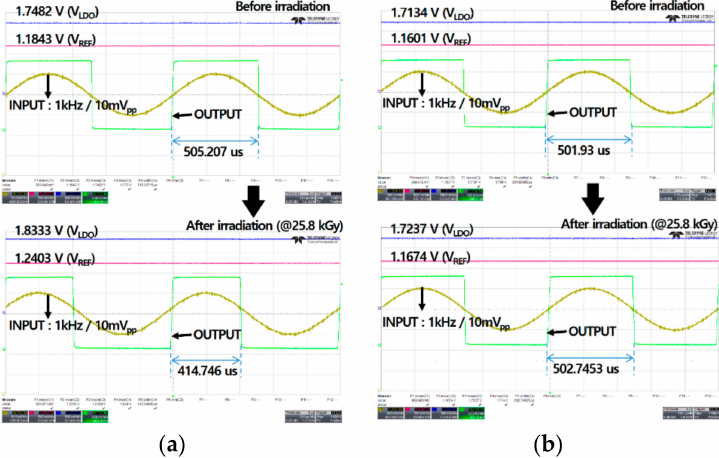
Figure 10. Electrical characteristics before and after irradiation with a cumulative radiation dose of 25.8 kGy of ( a ) the standard IA and ( b ) of the radiation-hardened IA.